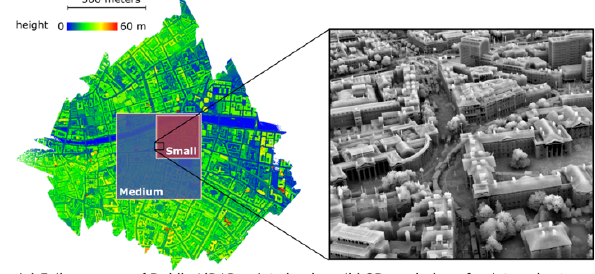
Figure 8. 2015 Dublin dataset